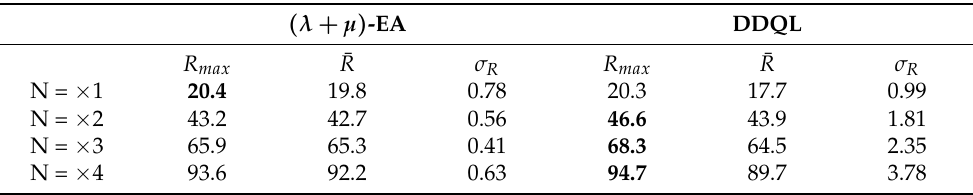
The bold indicates the best result between both